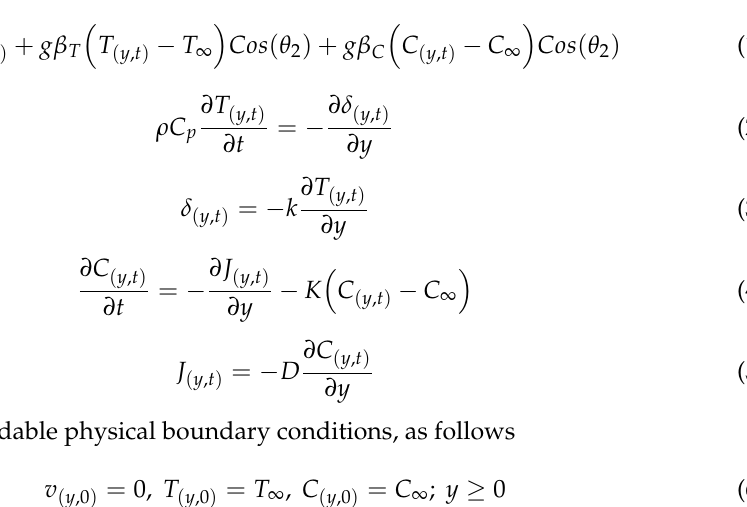
Figure 1. Flow Figure 1. Flow geometry.